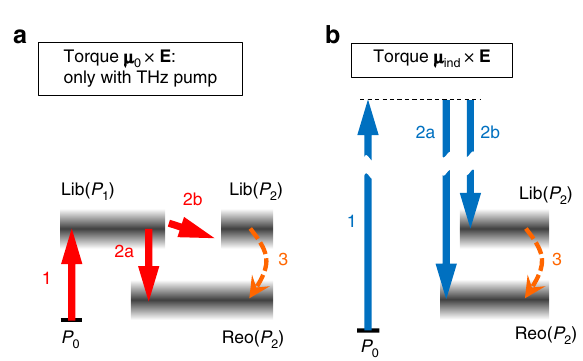
Figure 5 | Schematics of pump-driven transitions and relaxation pathways. ( a ) For THz excitation through l 0 (cid:3) E -type torque, the first field interaction (arrow 1) resonantly excites a P 1 -distributed libration Lib( P 1 ).